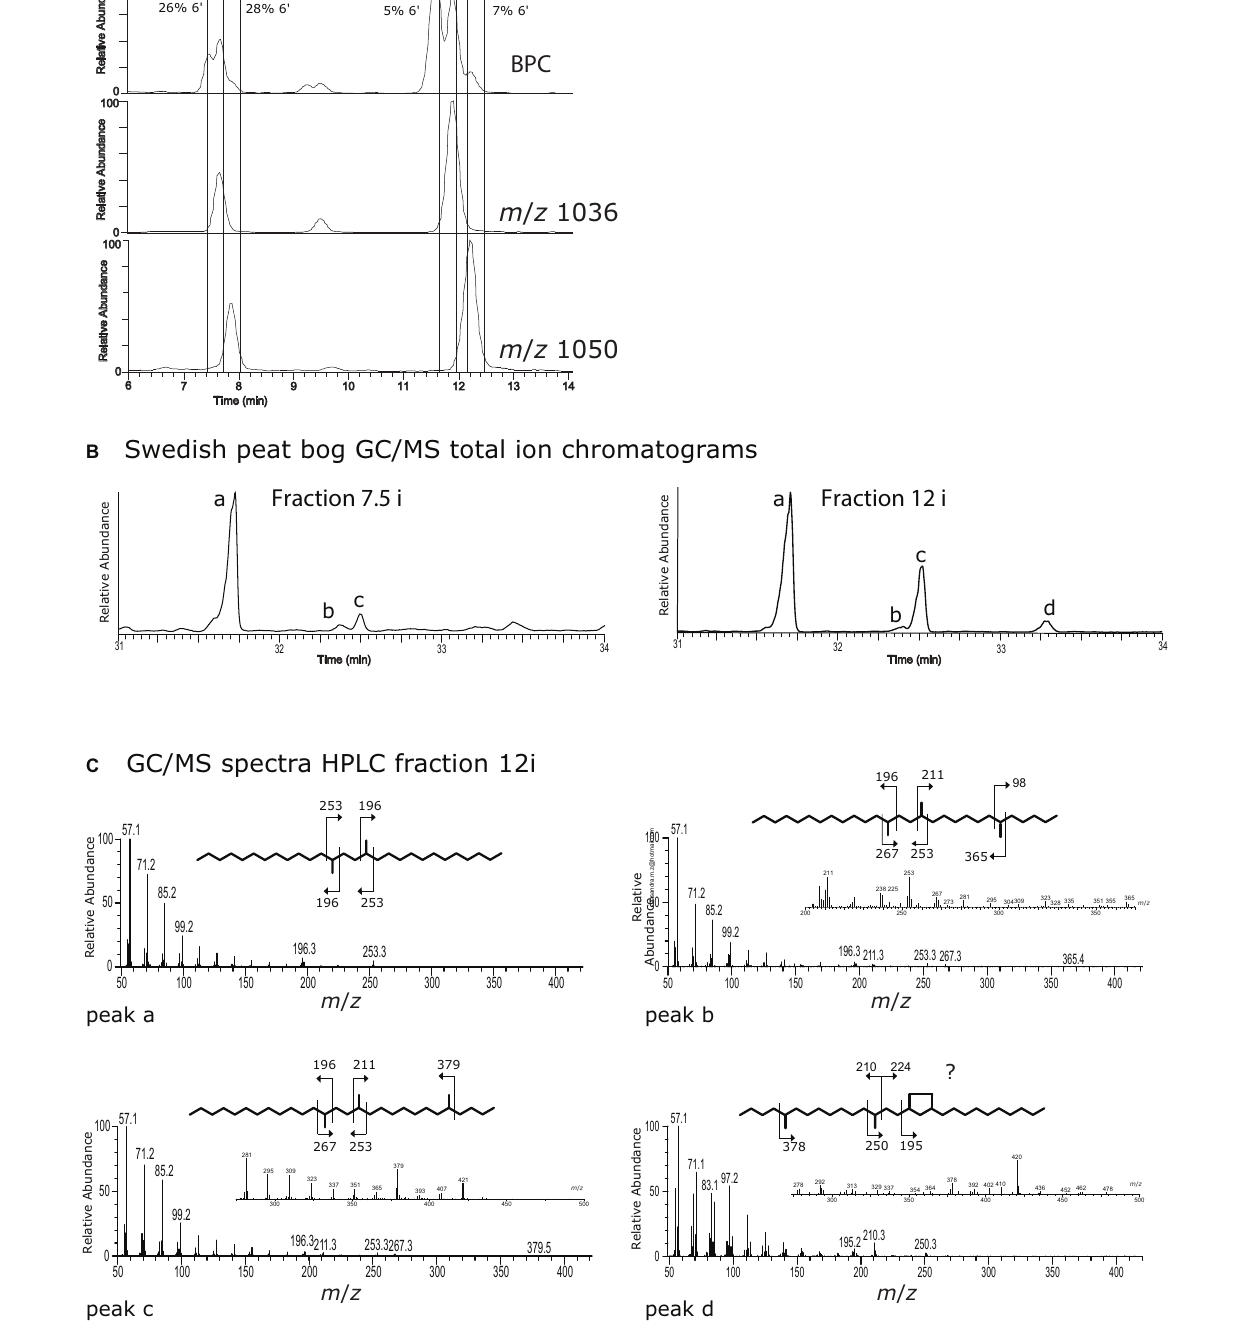
FIGURE 6 | (A) Partial base peak and m / z 1036 and m / z 1050 chromatograms from a Swedish Bog extract used for RP HPLC fraction collection. Boxes around 7.5 and 12 min show collection time windows where an earlier (i) and later (ii) fraction was taken at each collection time window. Fractions were subsequently ether cleaved and hydrogenated to elucidate the position (5 (cid:48) or 6 (cid:48) ) of the methyl group on the isomers. (B) GC-MS total ion chromatogram (TIC) from ether cleaved and hydrogenated HPLC fractions 7.5(i) and 12(i) from the Swedish peat bog. (C) GC-MS mass spectra from hydrocarbons a–d afforded from fraction 12(i) after ether cleavage and